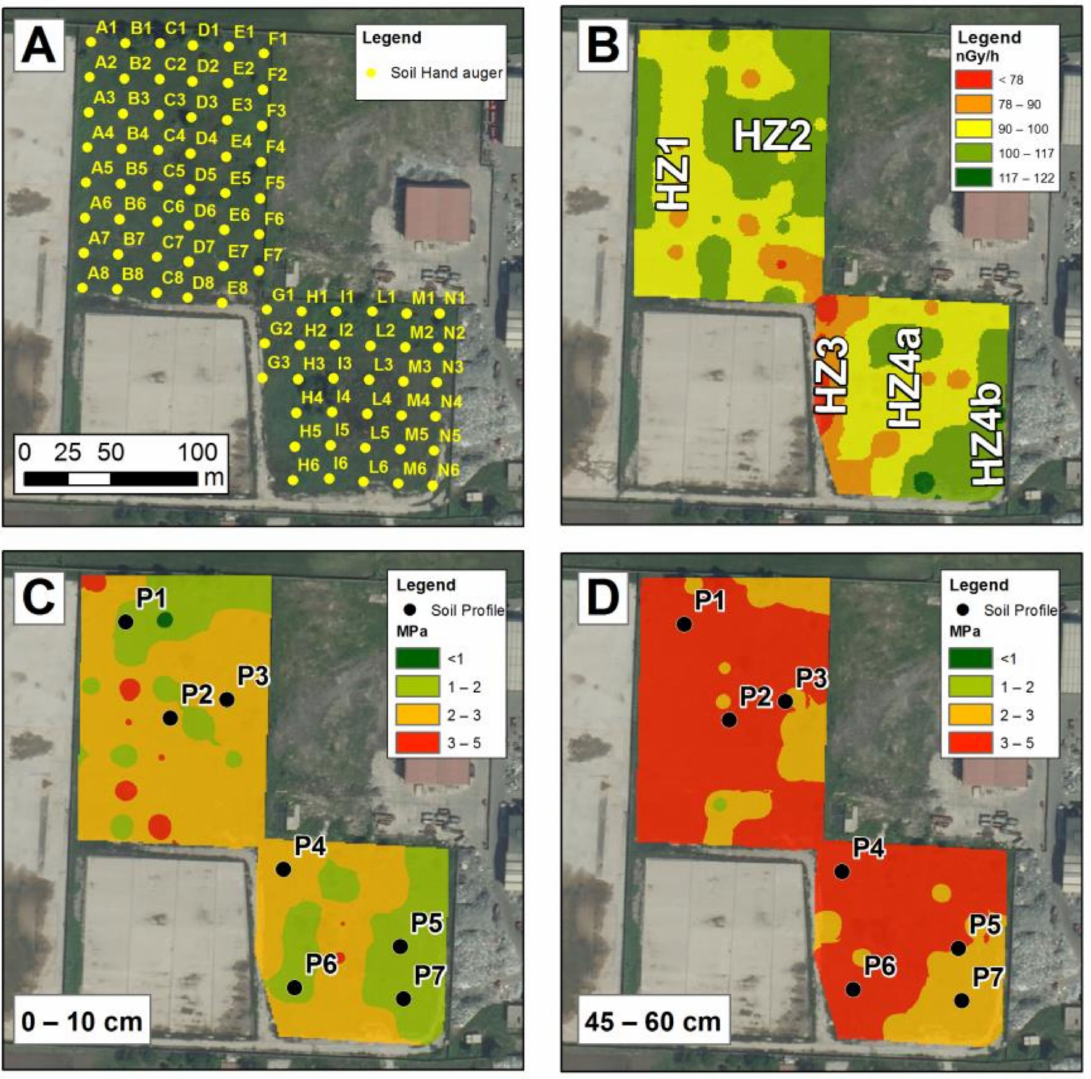
Figure 5. γ -rays dose rate and penetrometry ultrasound maps. ( A ) Sampling scheme; ( B ) γ -rays dose rate map; ( C , D ) cone index (CI) maps at 0–10 cm and 45–60